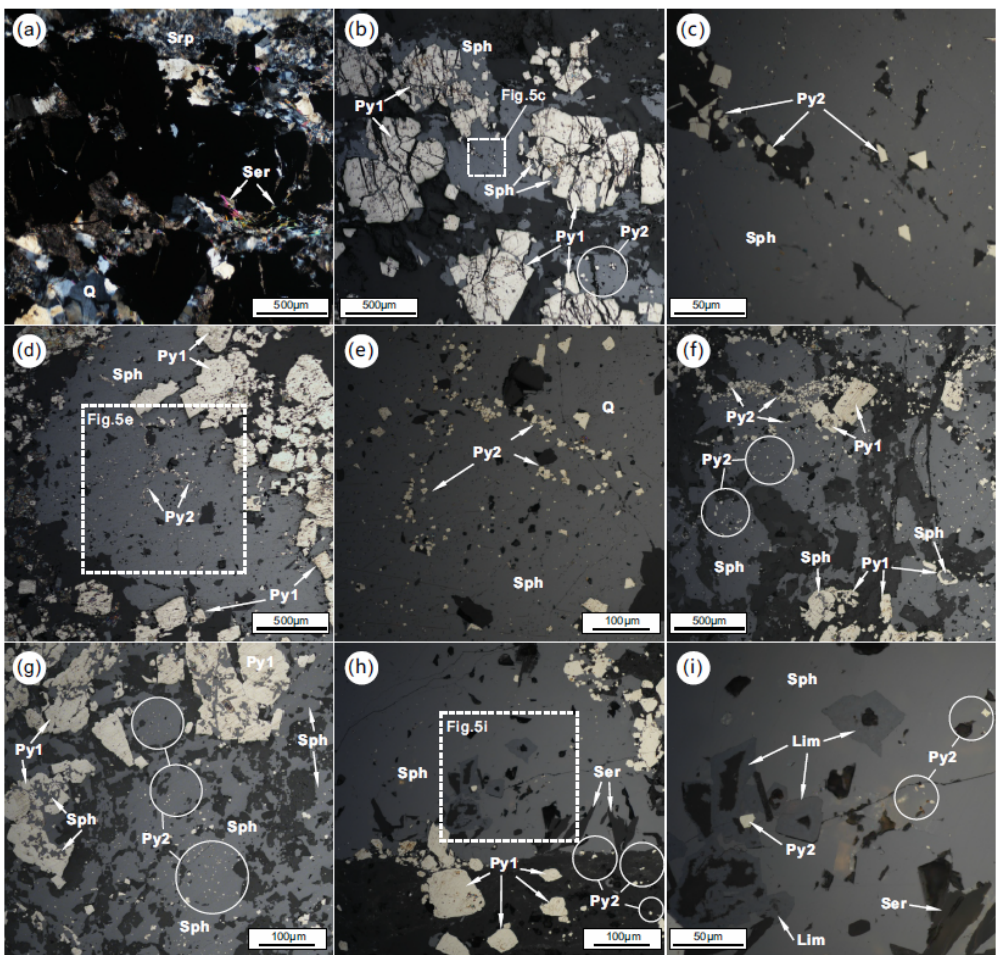
Figure 5. Photomicrographs showing the Liushuping ore petrography: ( a ) coarse-grained pyrite (Py1) replaced by metamorphosed quartz, calcite, dolomite, sericite, serpentine, etc.; ( b ) coarse ‐ grained pyrite (Py1) presents fragmented texture and replaced by sphalerite which coexists with a large amount of fine ‐ grained pyrite (Py2), the same position as photo ( a ); ( c ) coexistence of fine ‐ grained pyrite (Py2) and sphalerite from the stage 2 and exsolution texture between sphalerite and chalcopyrite; ( d ) coarse ‐ grained pyrite (Py1) replaced by sphalerite and fine ‐ grained pyrite (Py2), appearing metasomatic texture; ( e ) fine ‐ grained pyrite (Py2) appearing in clusters with euhedral and subhedral; ( f ) coarse-grained pyrite (Py1) replaced by sphalerite and clustered fine-grained pyrite (Py2), appearing metasomatic texture and metasomatic residual texture; ( g ) partial enlarged detail of photo ( f ); ( h ) limonite presents pseudomorphic pyrite; ( i ) partial enlarged detail of the photo ( h ). Abbreviations: Ccy—Chalcopyrite; Lim—limonite; Py—pyrite; Q—quartz; Ser—sericite; Srp—Serpentine; Sph—sphalerite.